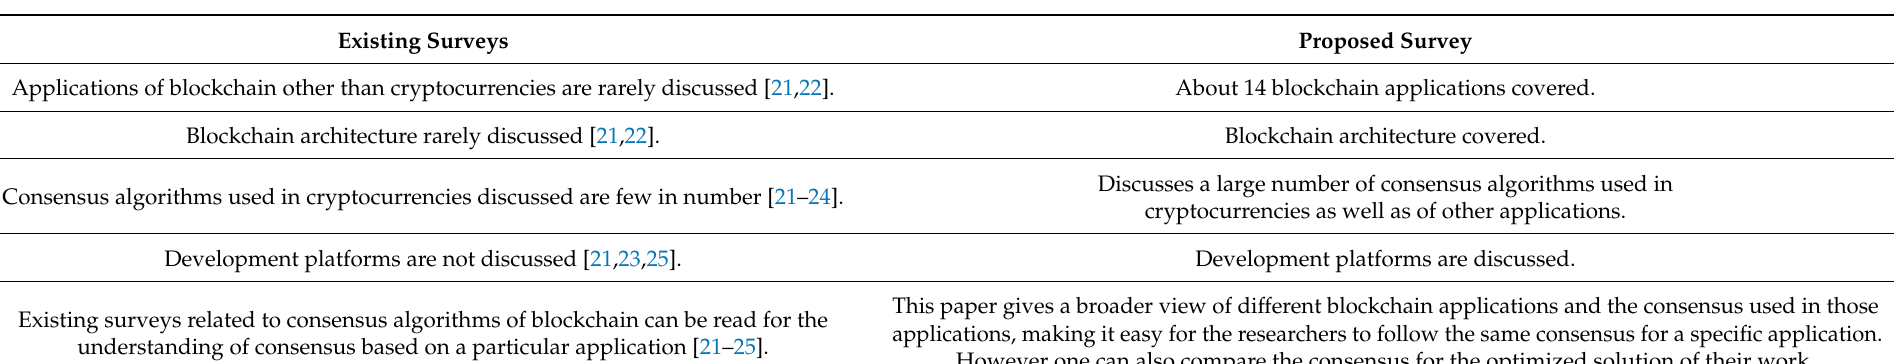
Table 2. Existing surveys vs. Proposed